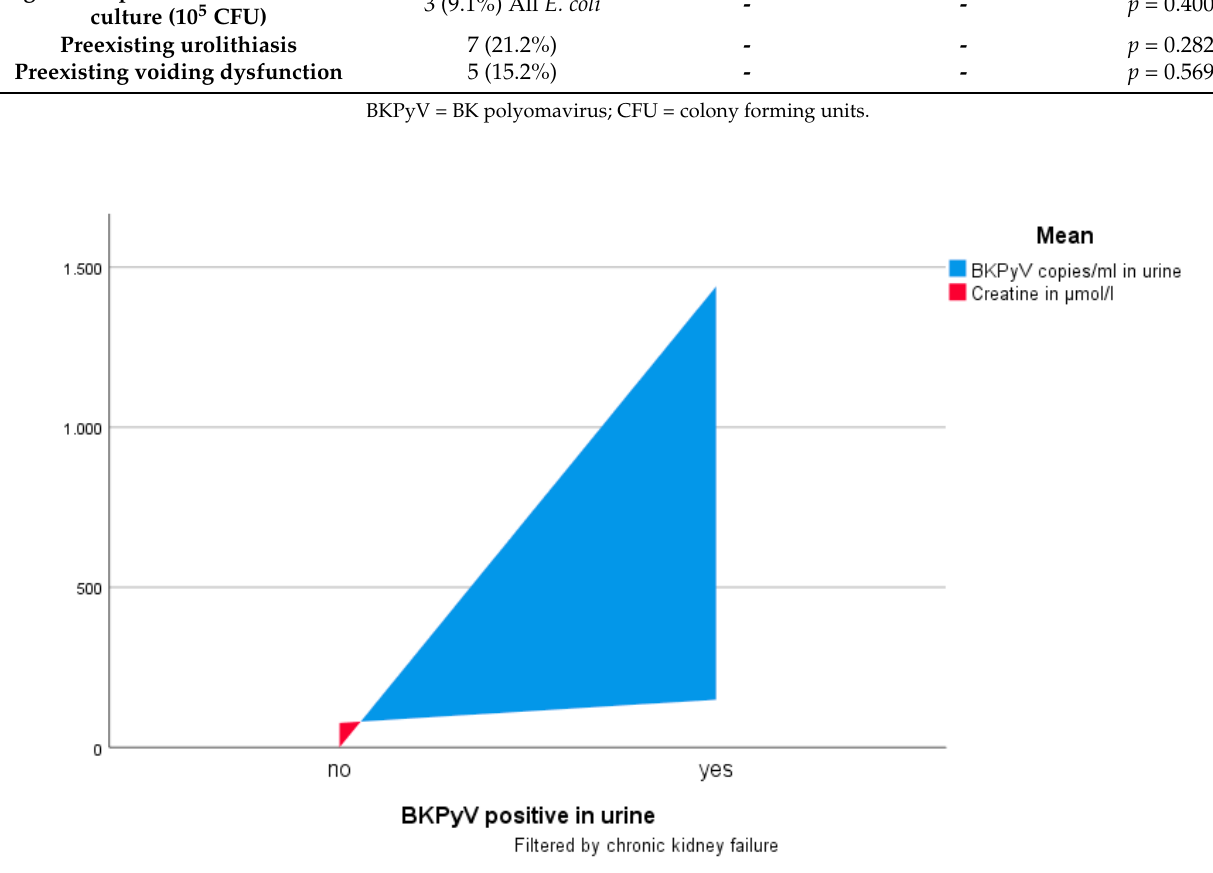
Figure 1. Association of creatine, BKPyV copies in urine, and chronic kidney failure.